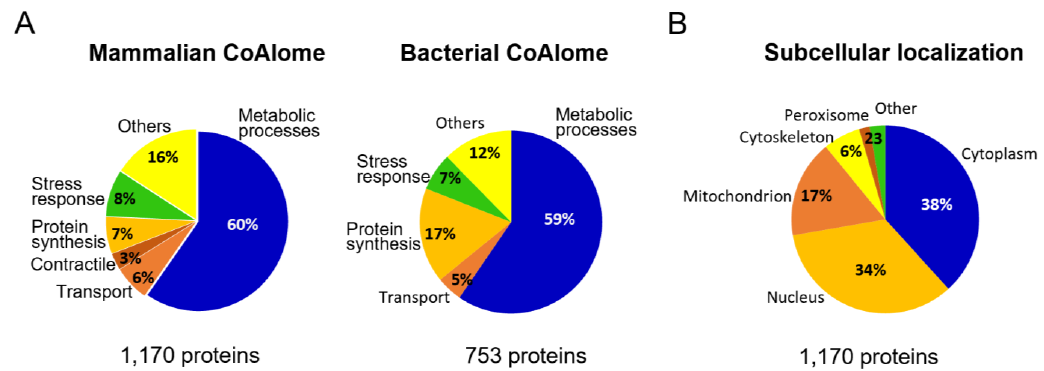
Figure 2. Functional analysis of CoAlated proteins and their subcellular localization. ( A ) Pie charts representing the molecular functions of mammalian and bacterial CoAlated proteins are shown. The percentages were calculated based on PANTHER (Protein ANalysis THrough Evolutionary Re- lationship — version 16) outputs. For both pie charts, metabolic processes represent the most pre- dominant functional group of all CoAlated proteins. Important to note is that within the bacterial dataset (923 proteins), 170 proteins had unknown functions and therefore, only 753 proteins were used for the PANTHER analysis. ( B ) Pie chart representing the subcellular localization of mamma- lian CoAlated proteins. The segregation of CoAlated proteins using DAVID database revealed that the majority of CoAlated proteins are located within the cytoplasm, followed by the nucleus and mitochondria.